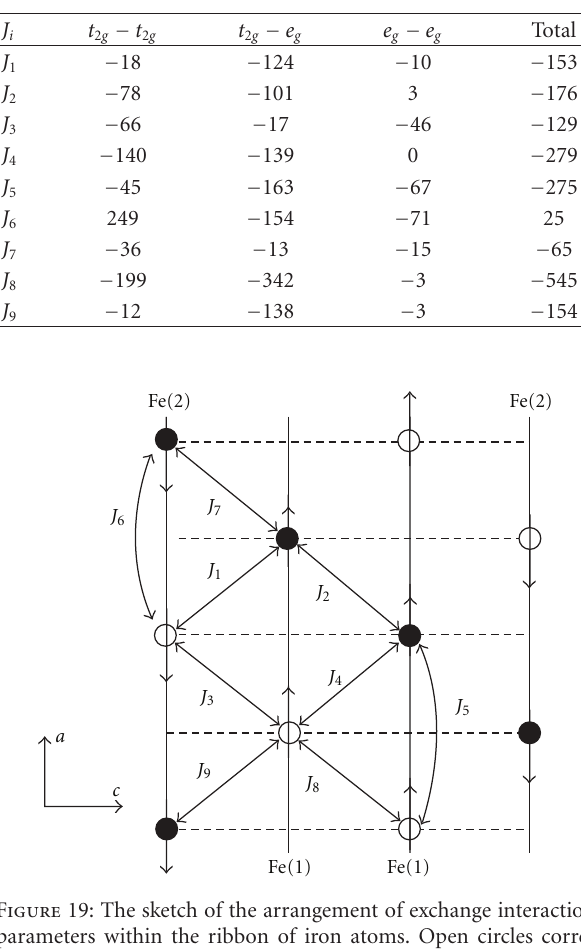
contrast with the ferromagnetic intrachain order due to d 5 − d 6 superexchange